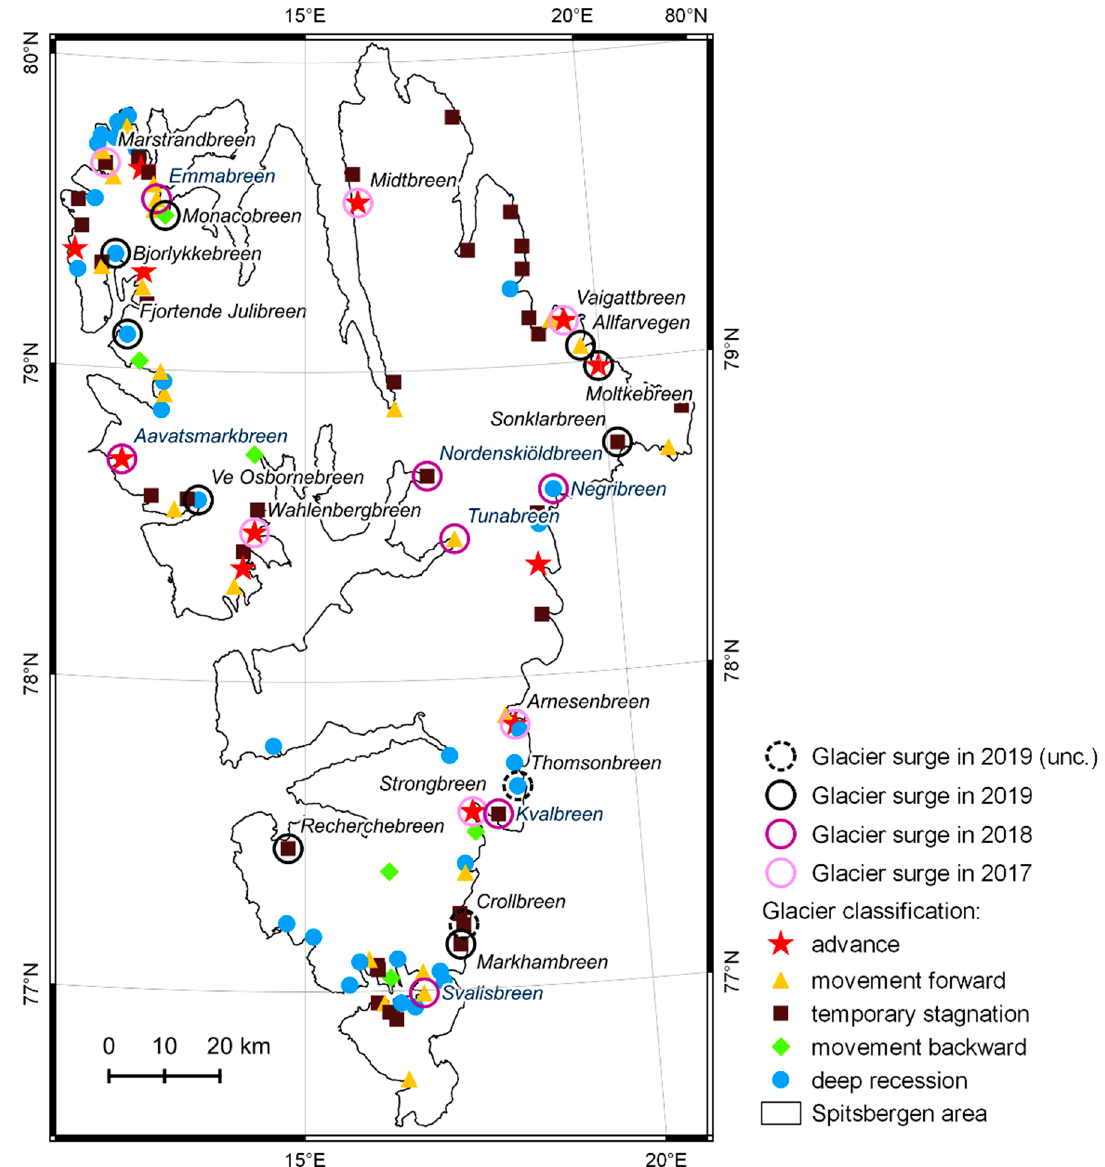
Figure 9. Classification of tidewater glaciers based on interannual changes of CfD and CfE between 2014 and 2017. Circles indicate glaciers with the characteristics of the active phase observed on satellite imagery in 2017, 2018, and 2019.